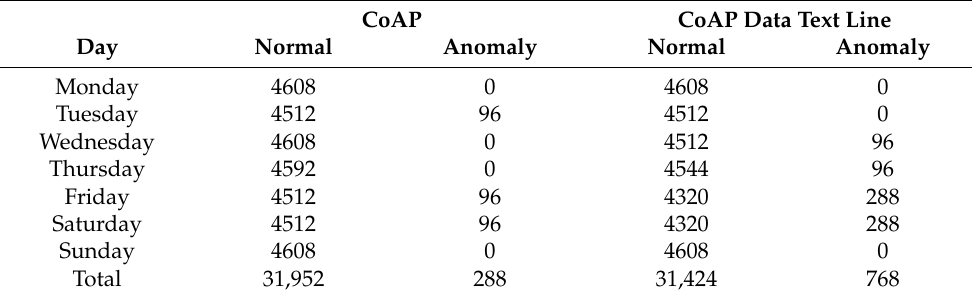
Table 4. UDP protocol